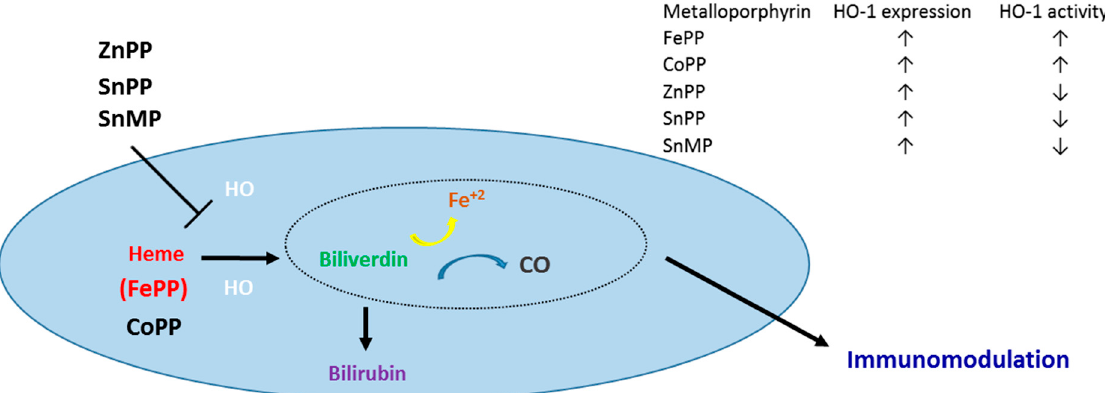
Figure 2. Effect of Mps on HO reaction and HO-1 expression and activity. Schematic representation of the HO reaction and the in vivo effect of various Mps which, depending on metal moiety, act either as HO activators/inducers (FePP and cobalt protoporphyrin, CoPP) or HO activity inhibitors (ZnPP, SnPP and tin mesoporphyrin, SnMP). Mps may also have a differential effect on HO-1 expression and activity in vivo.